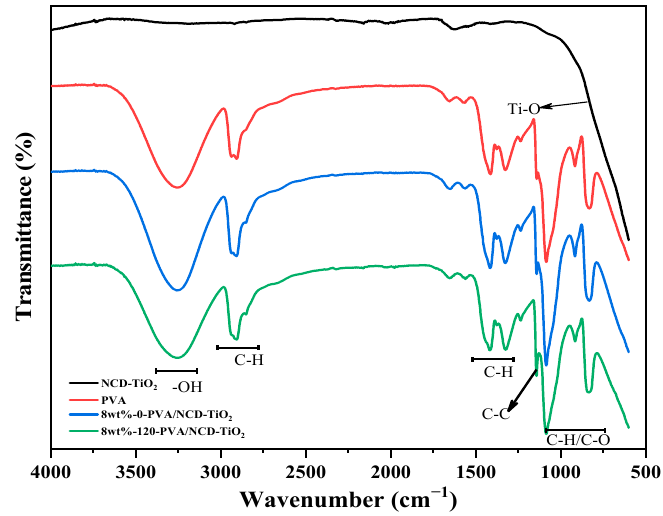
Figure 3. ATR/FTIR spectra of various samples.